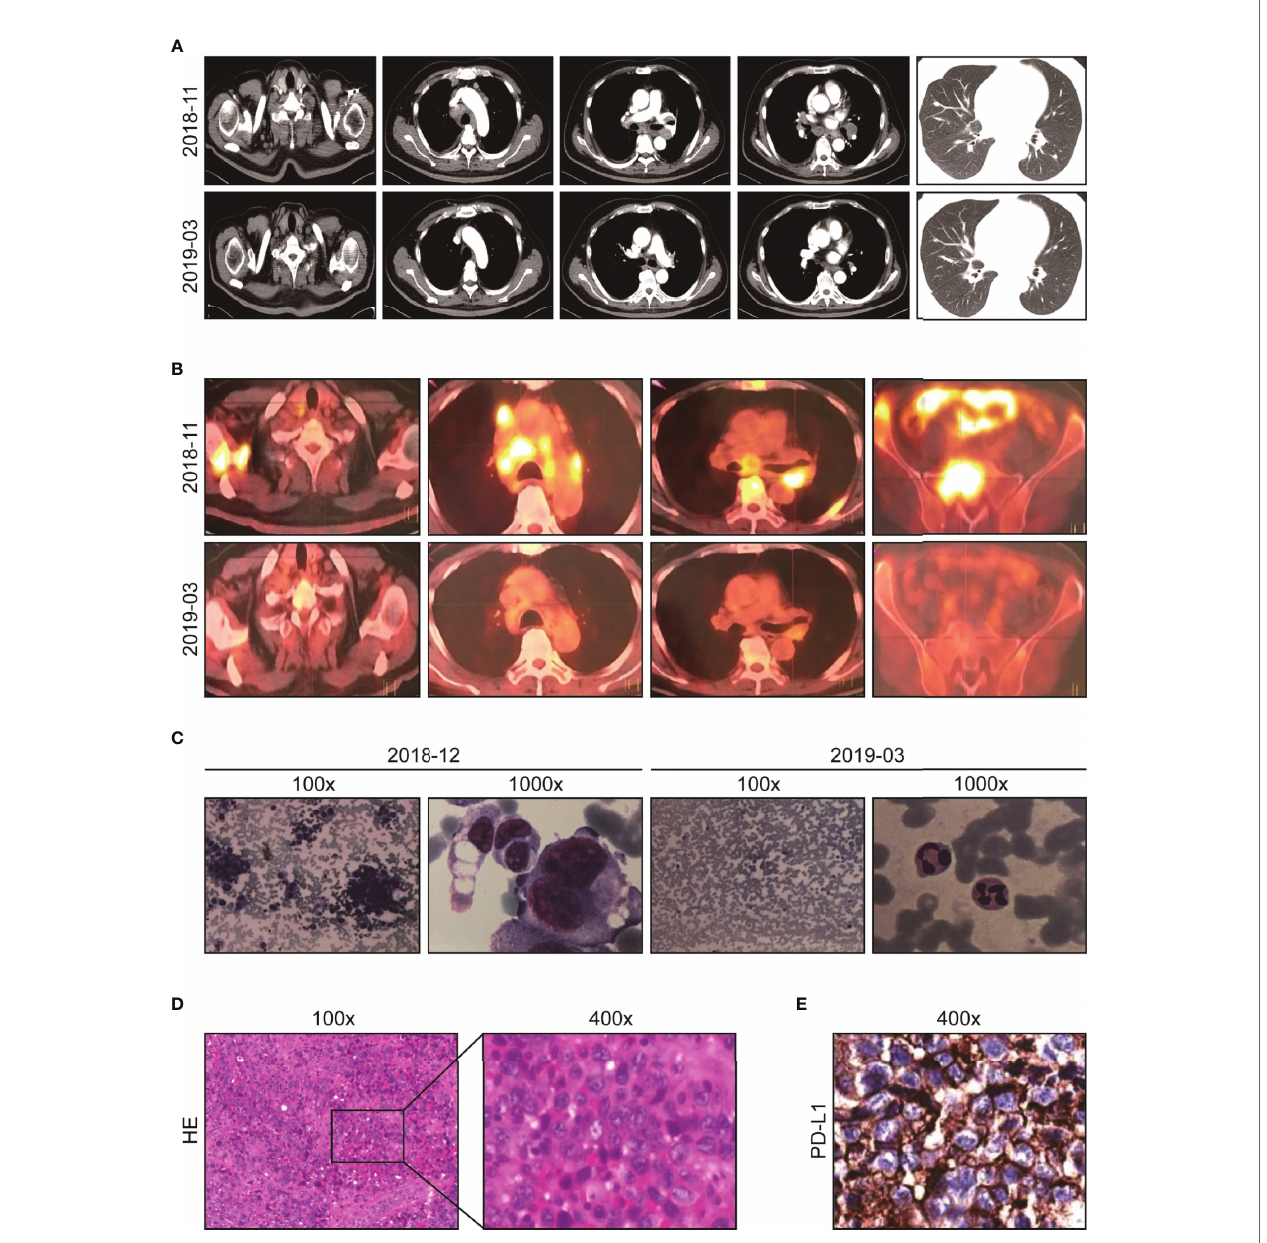
FIGURE 1 | Imaging and pathological data of the patient at diagnosis and after initial immuno-chemotherapy. (A) Representative chest CT before (upper) and after treatment (lower): abnormal lymph node in supraclavicular and mediastinum disappeared after two cycles of immuno-chemotherapy. (B) Representative PET-CT before (upper) and after treatment (lower): lesions with increased FDG uptake completely disappeared, and new bone generated after two cycles of immuno- chemotherapy. (C) Representative images of bone marrow aspiration cell smear: diffusely proliferative malignant tumor cells completely disappeared after two cycles of immuno-chemotherapy. (D) Pathological analysis (HE staining) of resected left supraclavicular lumps. (E) The protein expression of PD-L1 analyzed by IHC test (antibody clone number: